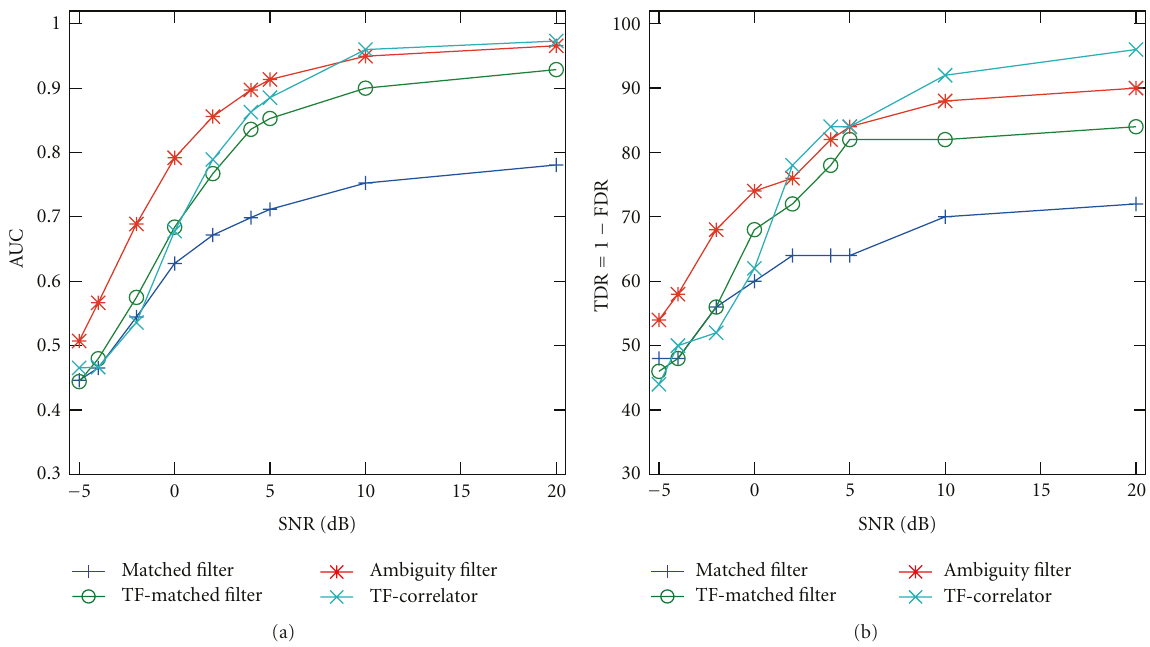
Figure 11: Detection results using speech signals. The test data is divided up into 50 epochs of noisy speech, for di ff erent levels of dB, and 50 epochs of